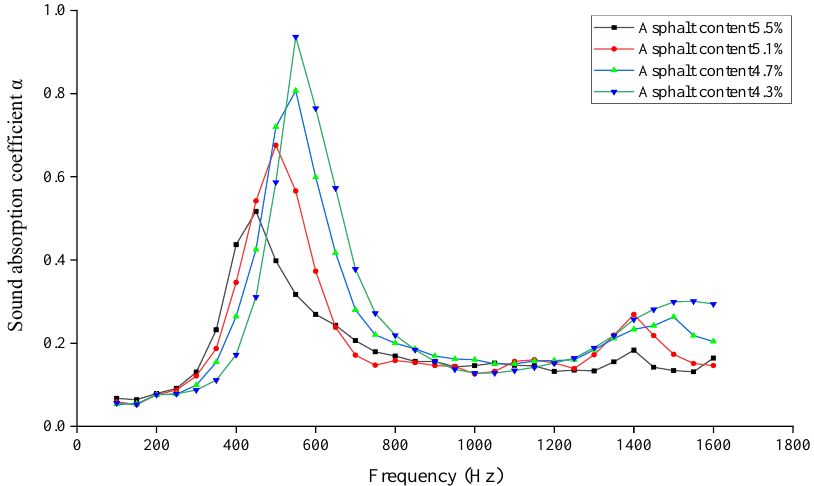
Figure 11. Variation trend of EPA-13 sound absorption coefficient with different asphalt contents.